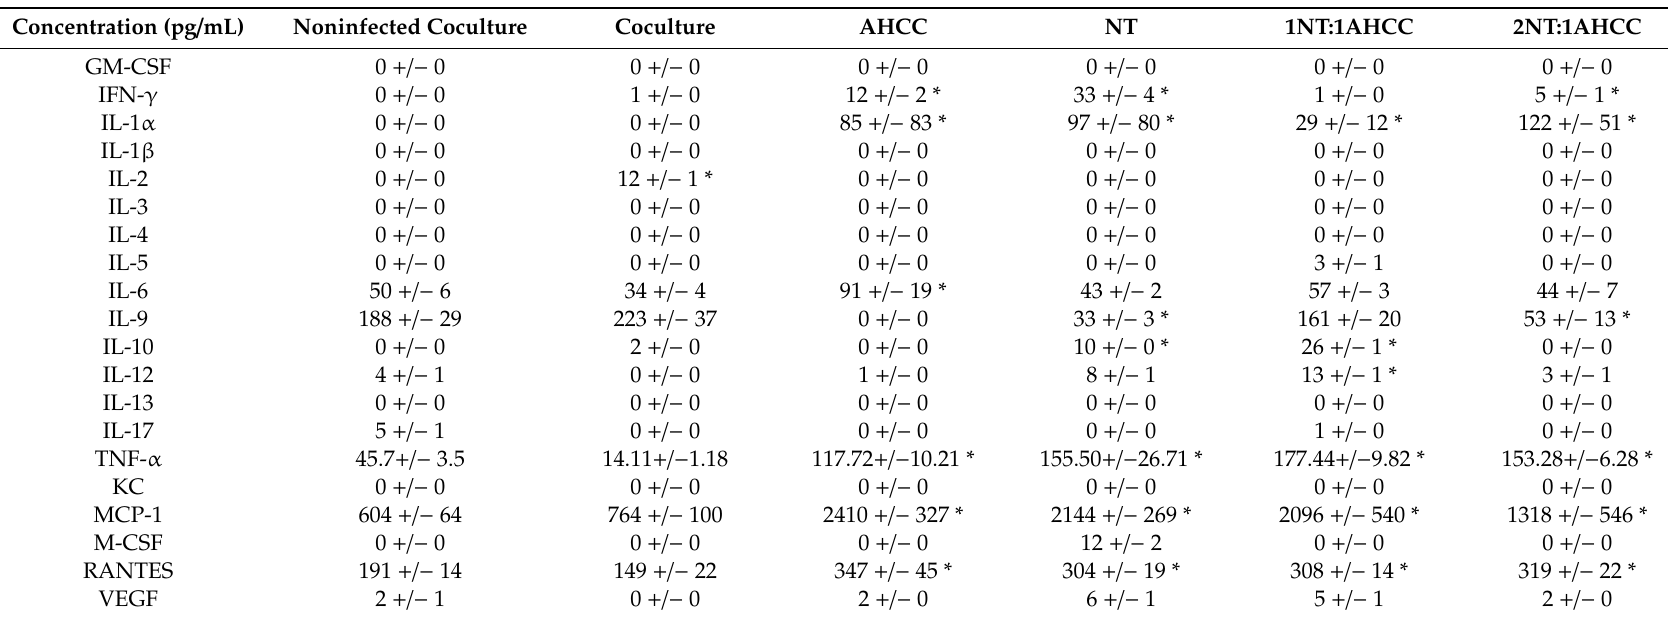
Table 3. Cytokine quantification after exposure of lymphocytes and L. infantum -infected macrophages to nucleotides (NTs), AHCC, and their combinations. Each value represents the mean +/ − standard deviation for three replicates. * p < 0.05 versus the control. Concentration (pg /